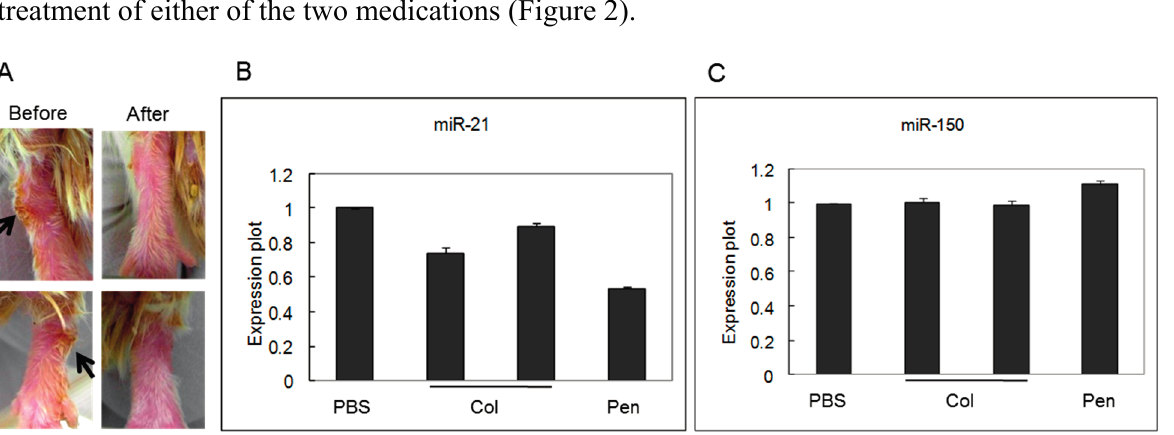
Figure 2. Cutaneous manifestation of mice was improved after pentoxifylline medication (arrows: skin lesion) ( A ); Expression of miR-21 was down-regulated by medication with either colchicine or pentoxifylline ( B ); miR-150 expression was not affected after medication ( C